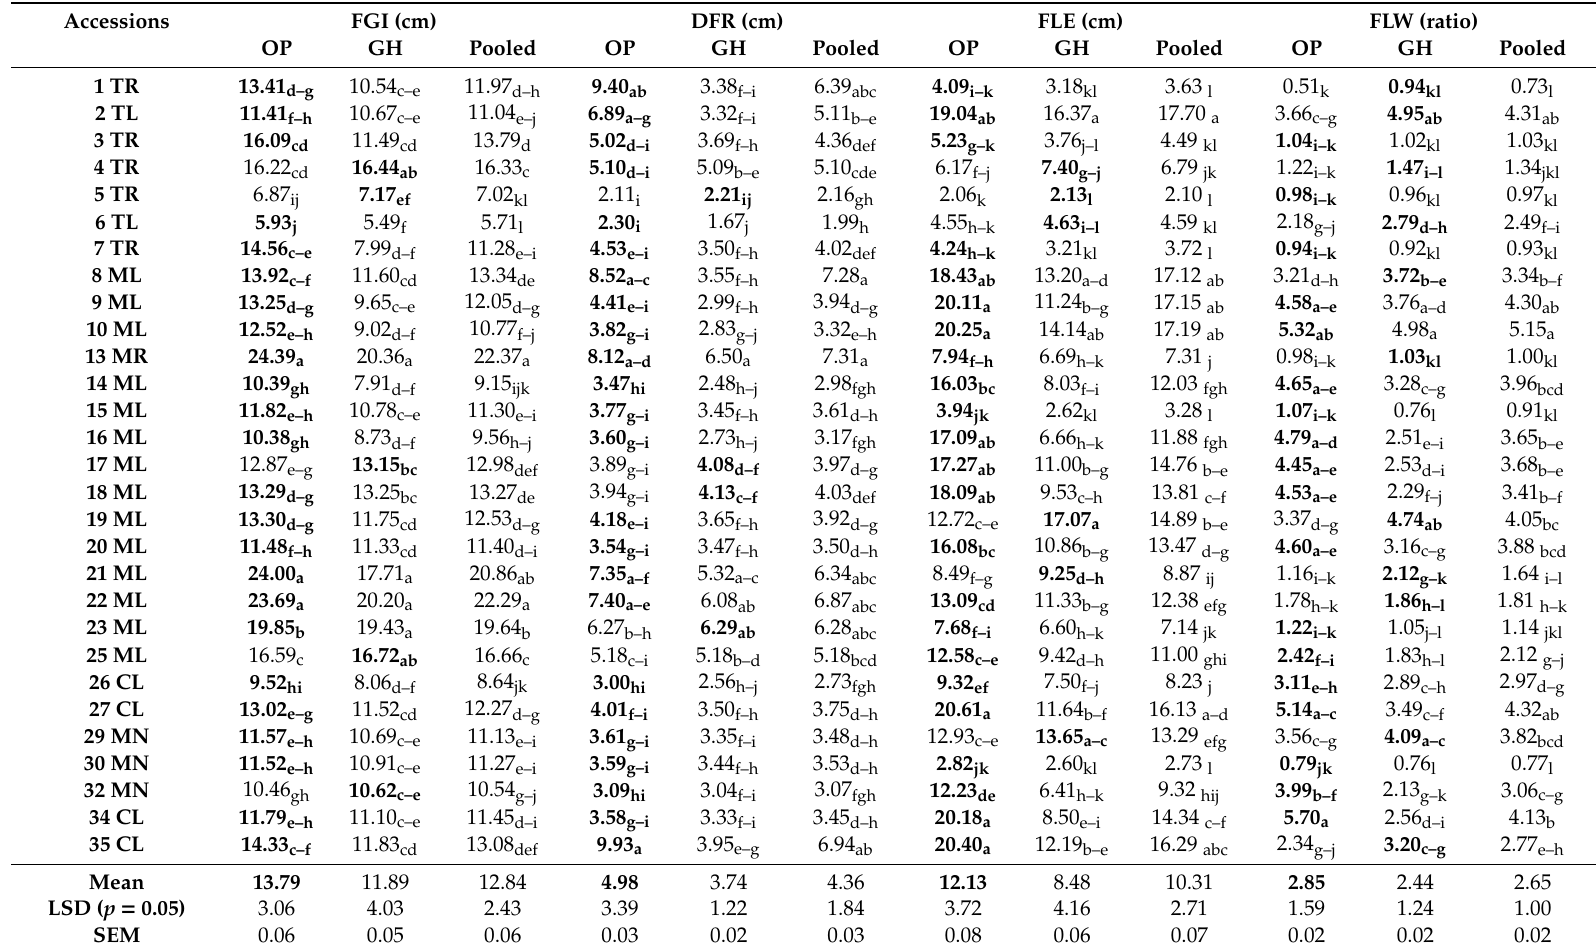
Table 3. Means yield and yield traits studied in 29 eggplant accessions across two cropping